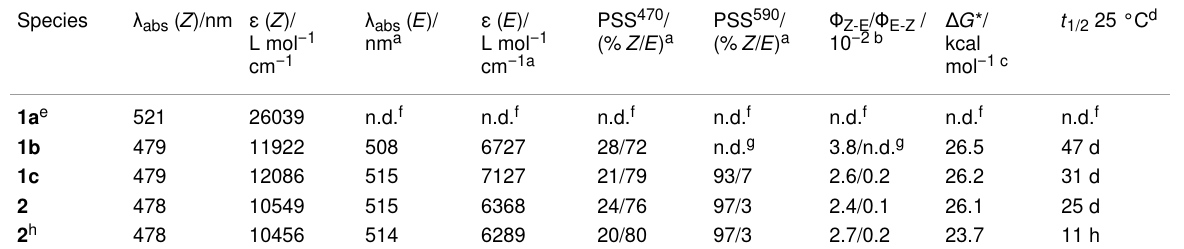
Table 1: Photochemical and photophysical properties of hemi-indigo derivatives 1a – c and 2 in water.